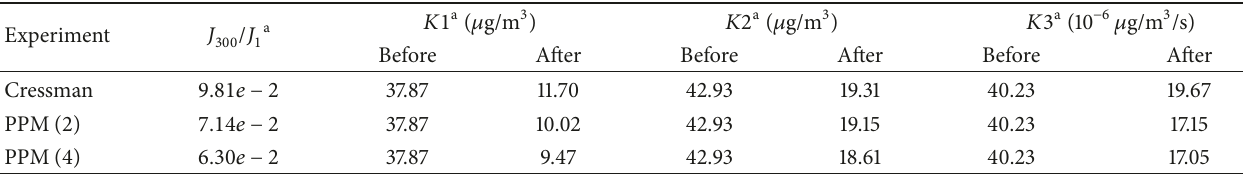
Table 5: Error statistics before and after assimilation.